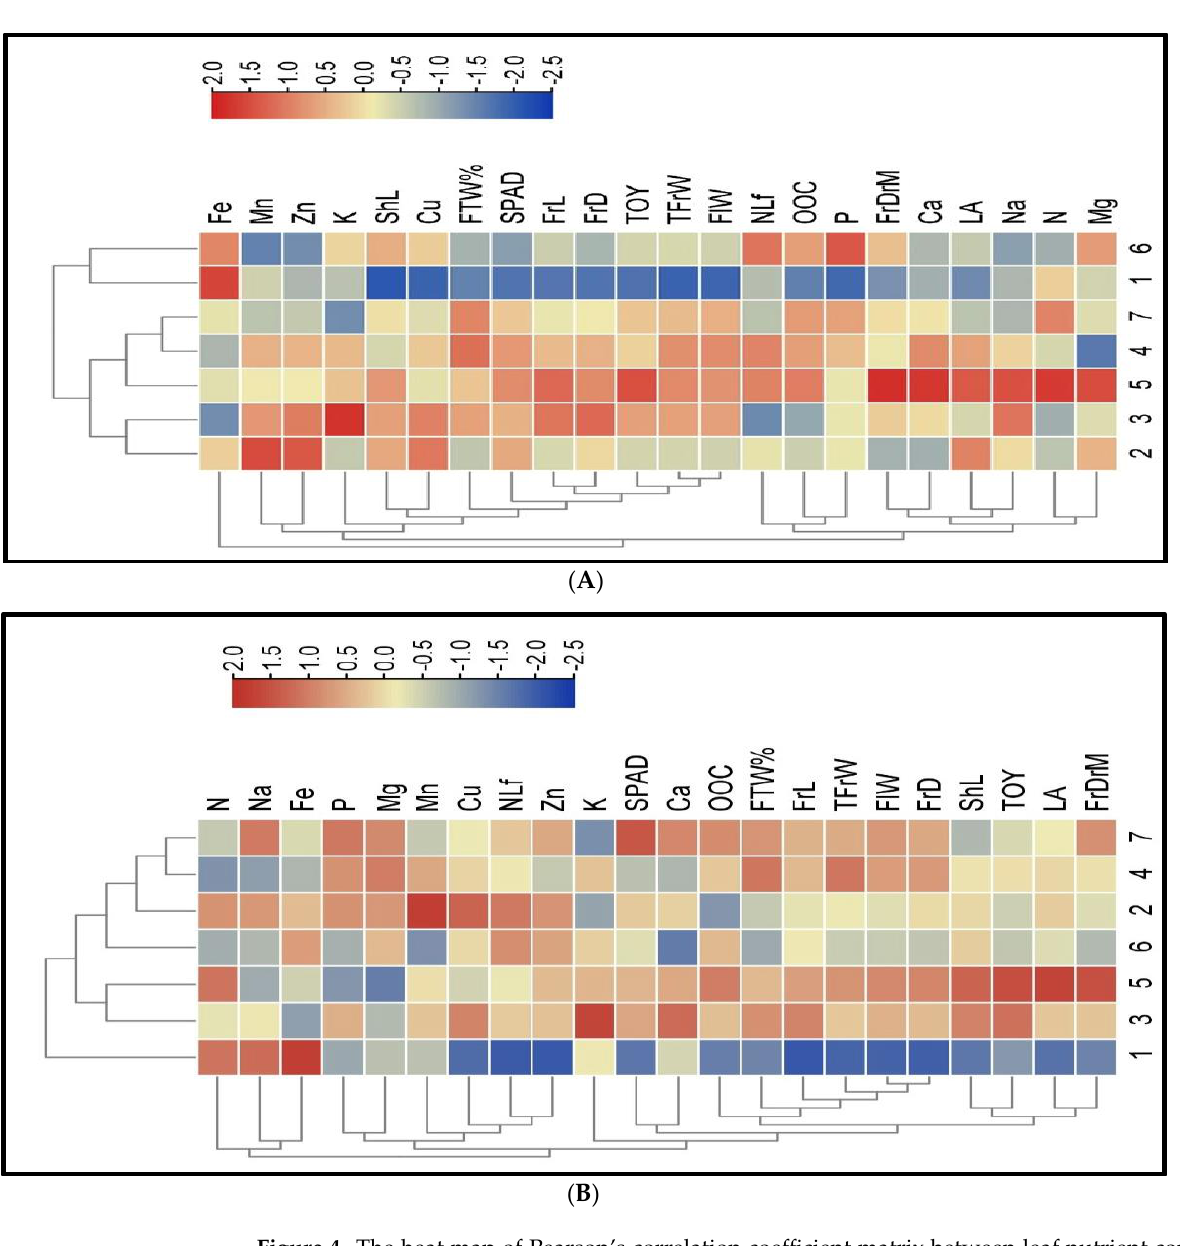
Figure 4. The heat map of Pearson’s correlation coefficient matrix between leaf nutrient contents (N, P, K, Ca, Mg, and Na) with physiological parameters (ShL, NLf, LA, and SPAD reading) and yield and its attributes (TFrW, FiW%, FrL, FrW, FrDrM, and TOY) in the 2018 ( A ) and 2019 seasons ( B ).